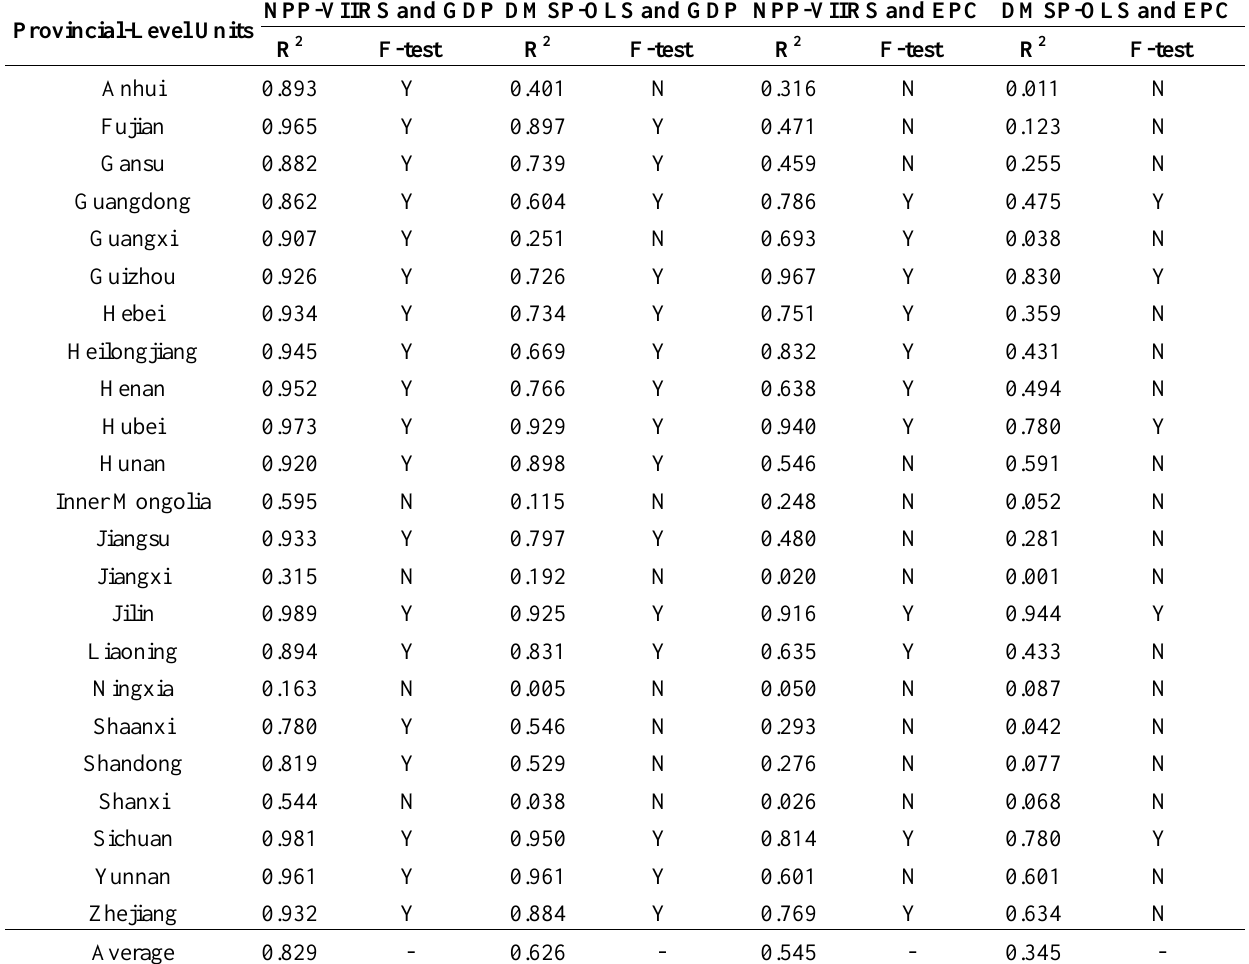
Table 3. R 2 values and F-tests of the linear regressions analysis for prefectural units of each province. Note: Y represents the regression has passed the F-test at the 0.001 level, N represents the regression has not passed the test, GDP represents the statistical gross domestic product, EPC represents the statistical electric power